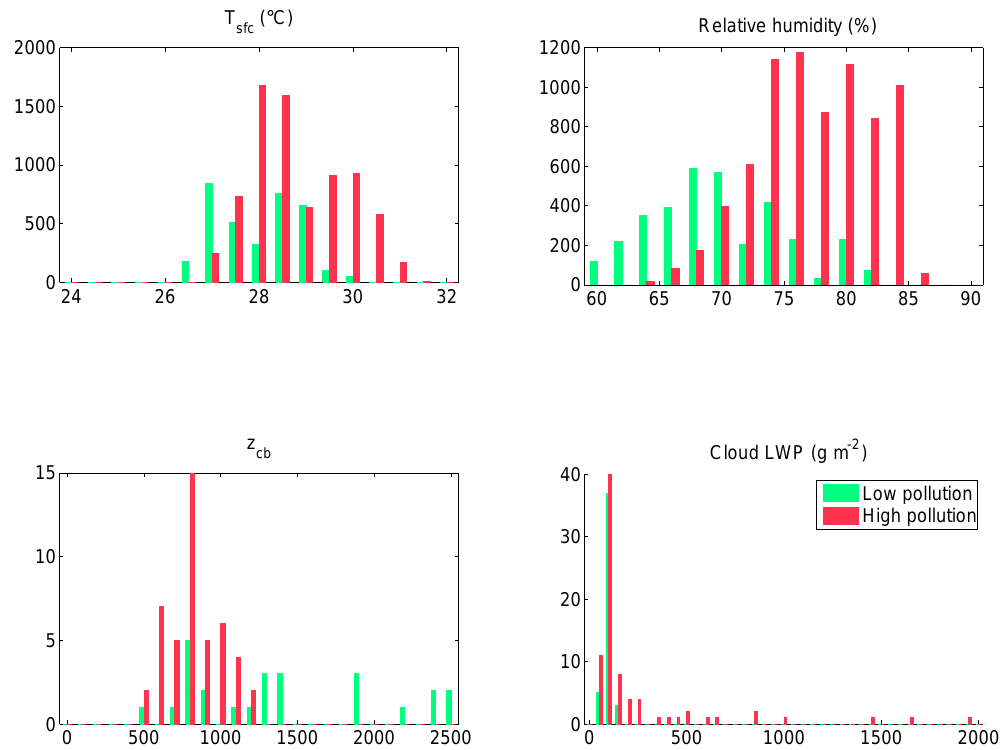
Figure 8. Frequency distributions of surface air temperature and relative humidity (minute data from MCOH), cloud base height (cloud- averaged data from MPL), and cloud liquid water path (cloud-averaged data from MWR) for low- vs. high-pollution